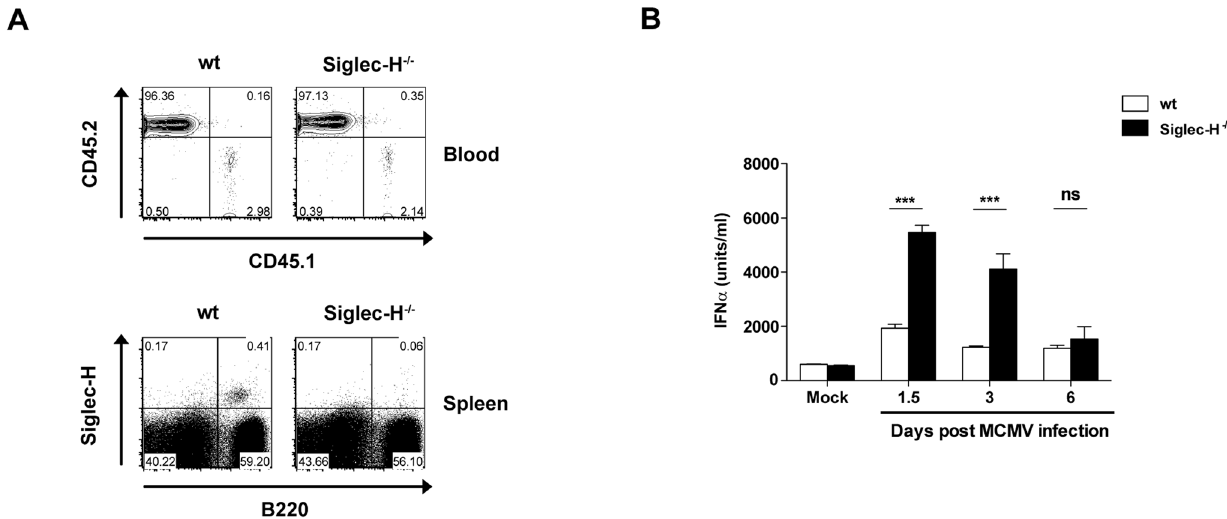
Figure 5. IFN a serum levels are elevated in the absence of Siglec-H upon MCMV infection. Lethally irradiated CD45.1 + wt mice were reconstituted with CD45.2 + wt or Siglec-H 2 / 2 BM followed by infection with 5 6 10 4 PFU of wt MCMV. ( A ) FACS plots show efficient donor reconstitution in the blood eight weeks after BM transfer (upper panel). Siglec-H and B220 stainings of splenocytes confirm the lack of Siglec-H expression in wt mice reconstituted with Siglec-H 2 / 2 BM (lower panel). ( B ) The kinetics of serum IFN a levels 1.5, 3 and 6 days p.i. compared between Siglec-H 2 / 2 and wt mice, n=4–5 mice/group. Data are from one of two individual experiments with similar results. ns=not significant *** p , 0.001, Students